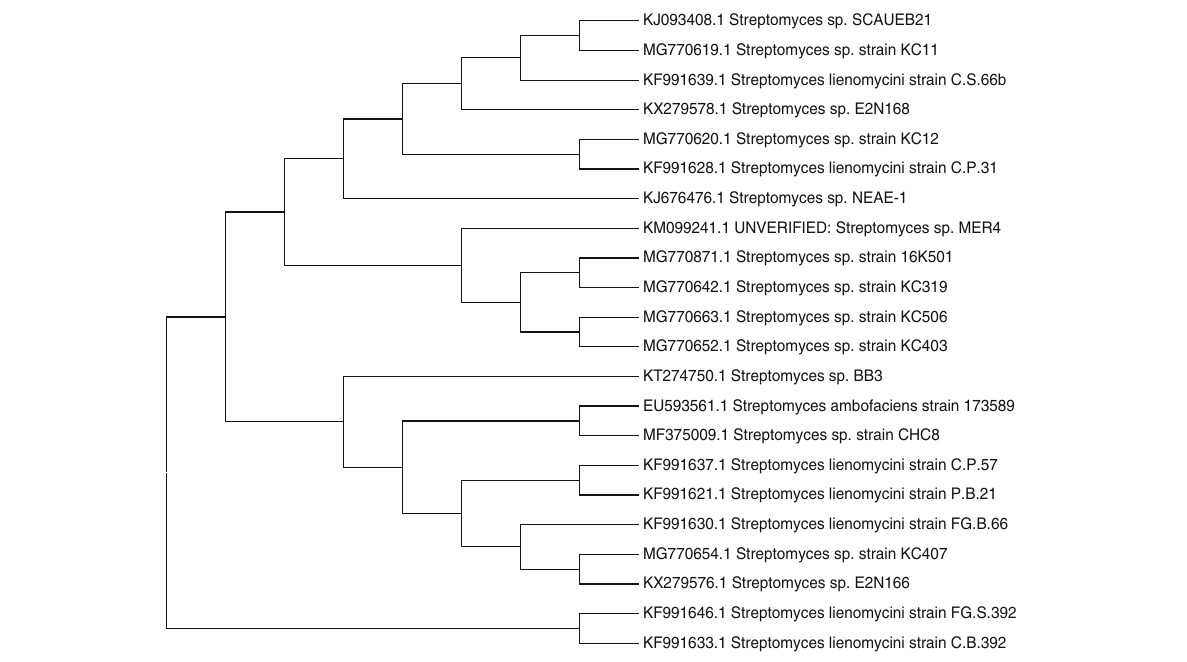
Fig. 1 Phylogenetic tree of the Streptomyces sp. MER4 strain (accession no. KM099241). The phylogenetic tree has been reconstructed using MEGA7